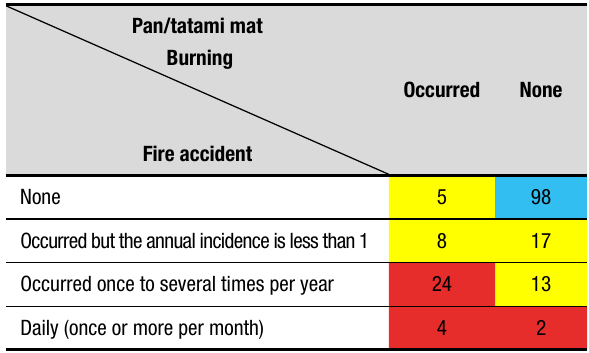
Table 1. Risk classification of fire accident.